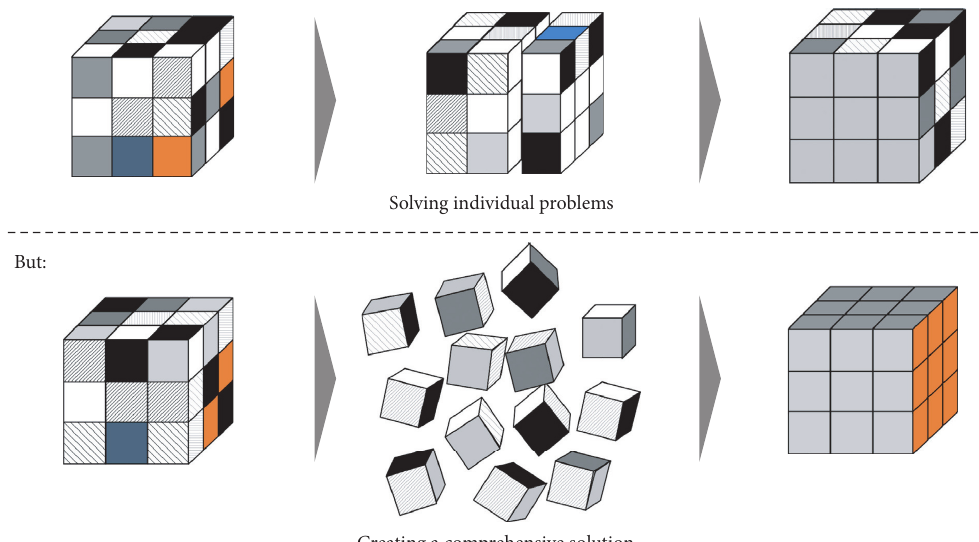
Figure 8: The research methods of this